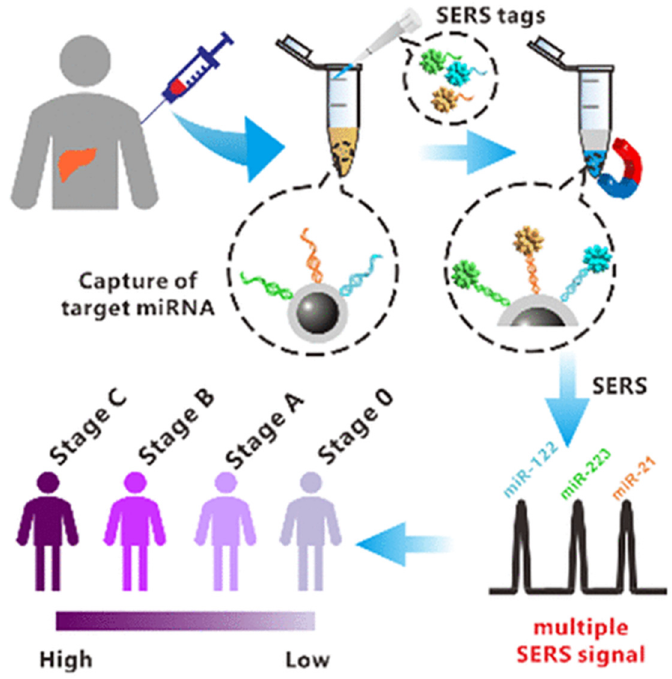
Figure 5. Schematic illustration of the use of a SERS-based method for the early diagnosis and prognosis of hepatocellular carcinoma. Reproduced with permission from [68]. Copyright 2021, American Chemical Society.